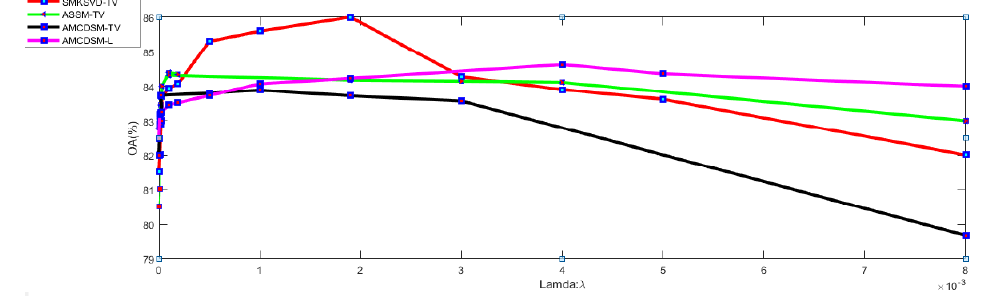
Figure 13. Overall Accuracy (%) of four algorithms in relation to